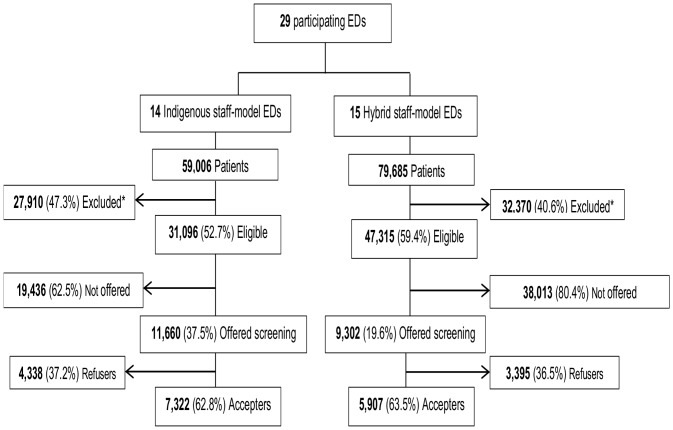
Patient flow diagram.*Exclusion criteria were the following: age <18 years or age >65 years (51%), serious/unstable illness (15%), inability to provide consent (31%), known HIV seropositivity (2%).